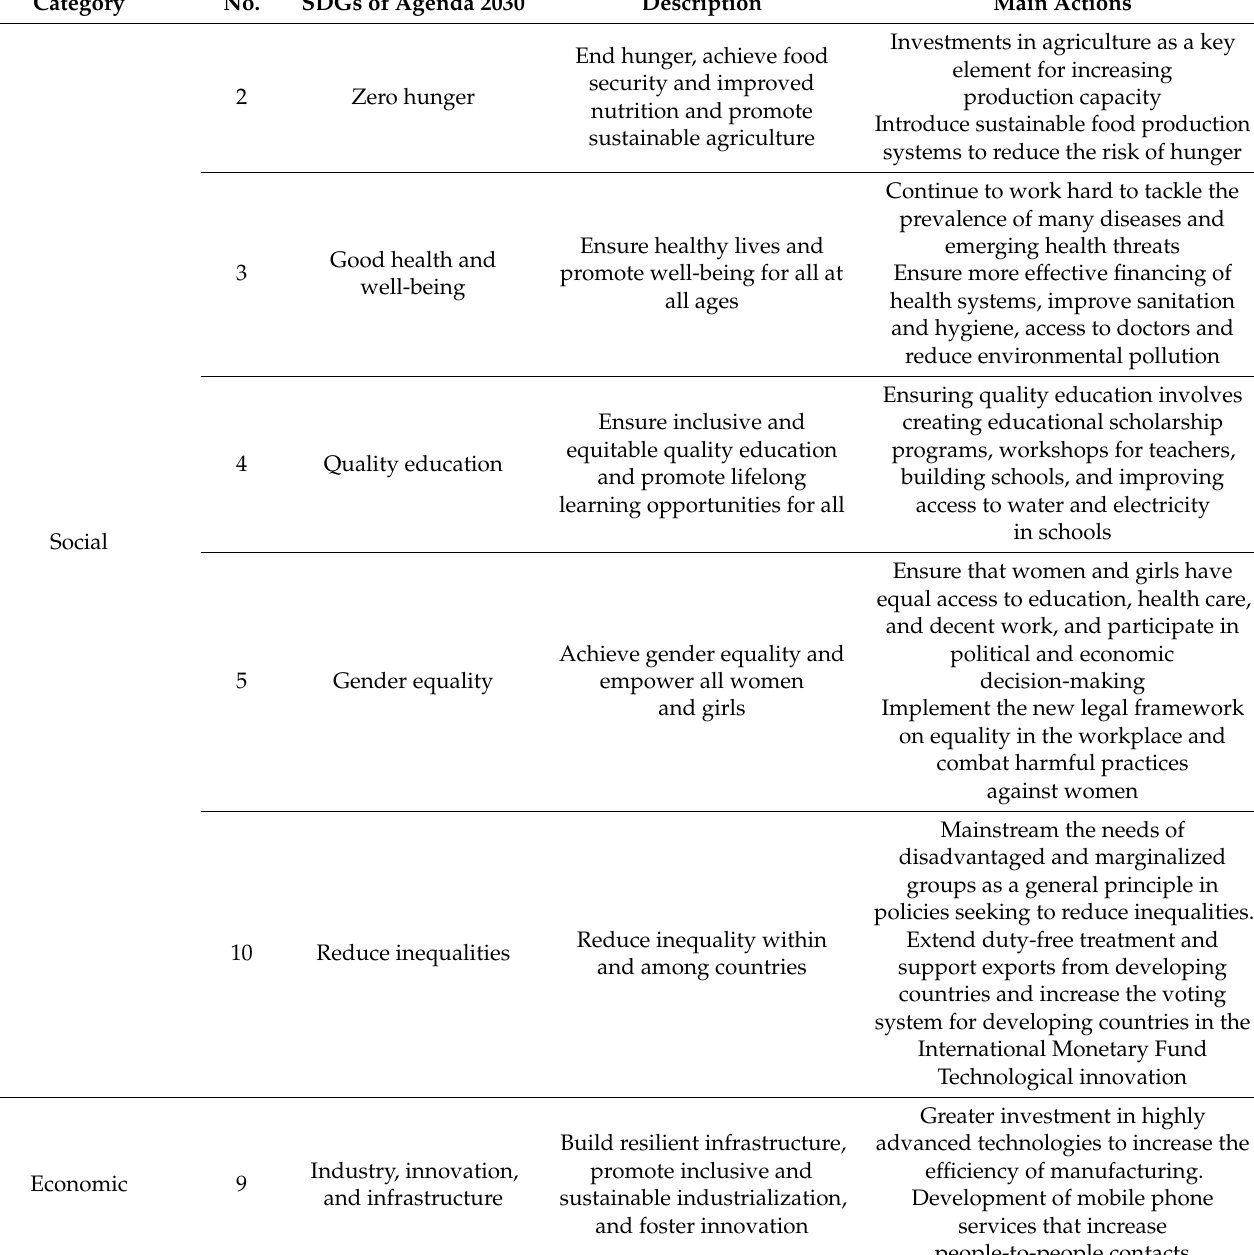
Table 1. SDGs of Agenda